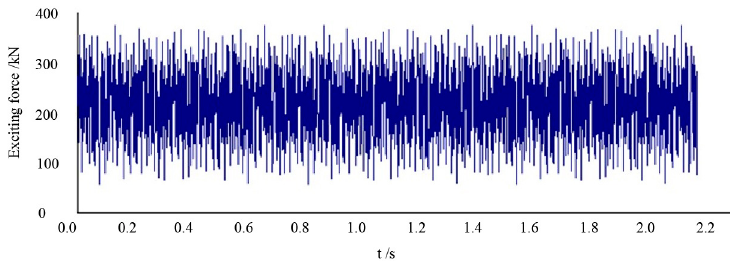
Figure 5. Time-history curve of the train load.